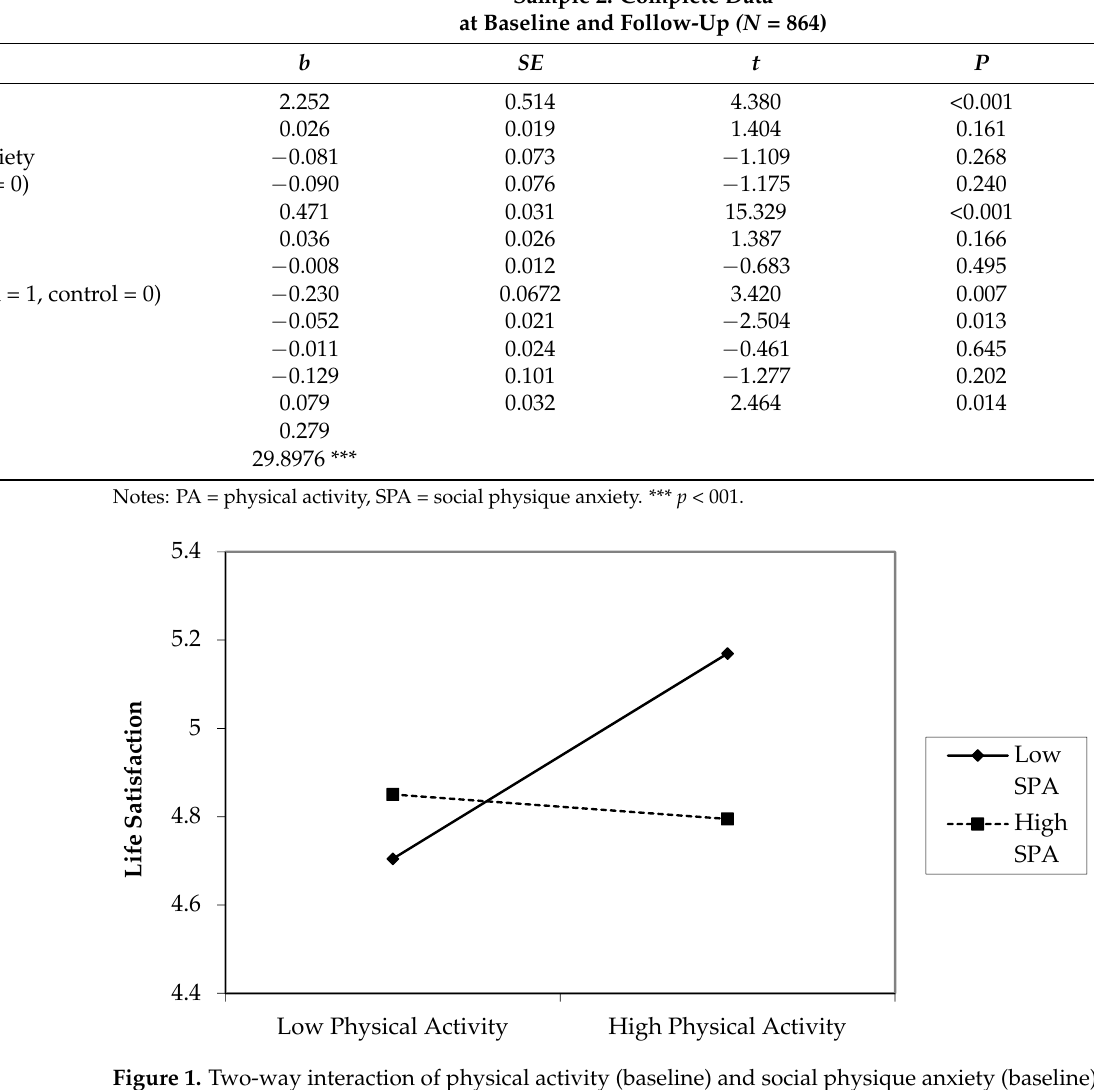
Figure 1. Two-way interaction of physical activity (baseline) and social physique anxiety (baseline) on life satisfaction (follow-up) for both sexes. Notes: SPA = social physique anxiety.